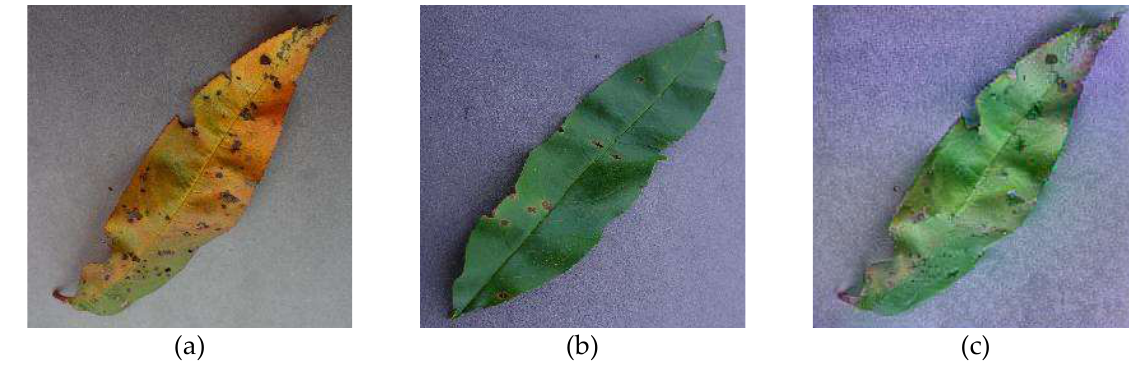
Figure 2. NST technique: ( a ) Content image; ( b ) style reference image; ( c ) output image.